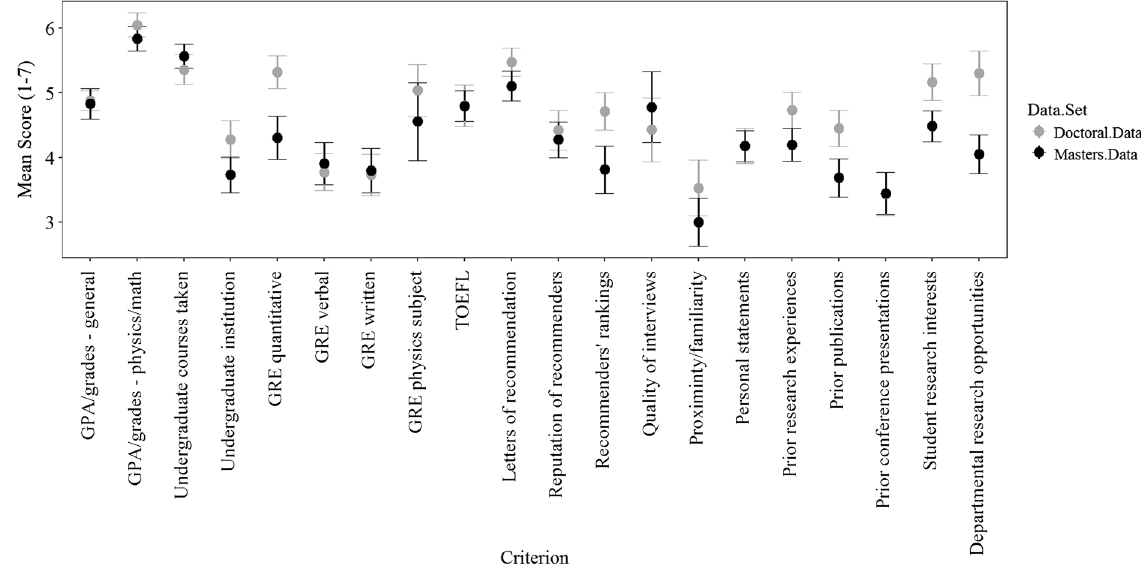
FIG. 6. Mean response of various admission criteria in a subset of master ’ s ( n ¼ 33 ) and Ph.D. ( n ¼ 28 ) programs.